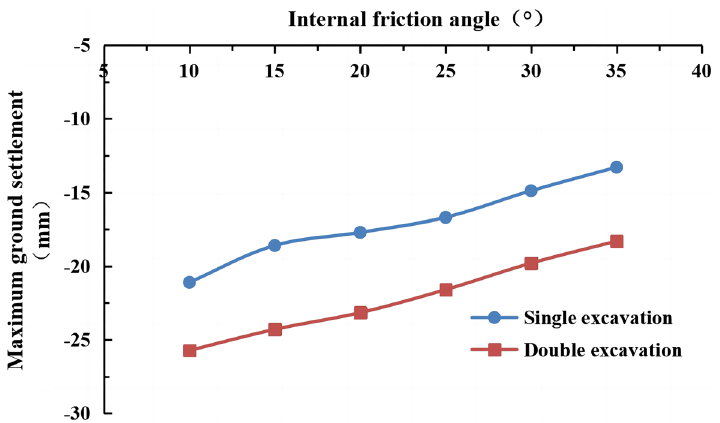
Figure 24. The maximum surface settlement during single-line and double-line excavation for different internal friction angles.